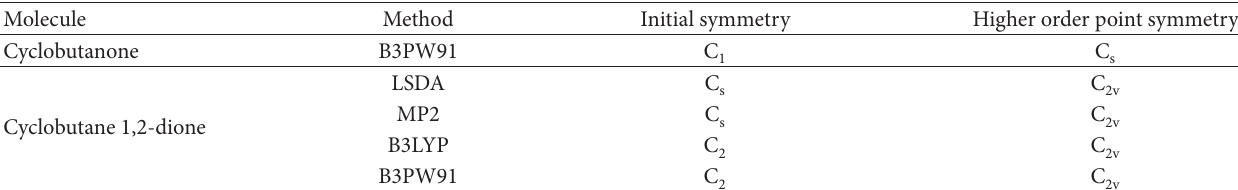
bond in ethane (1.53 Å) [24] and in higher n-alkynes 1.53